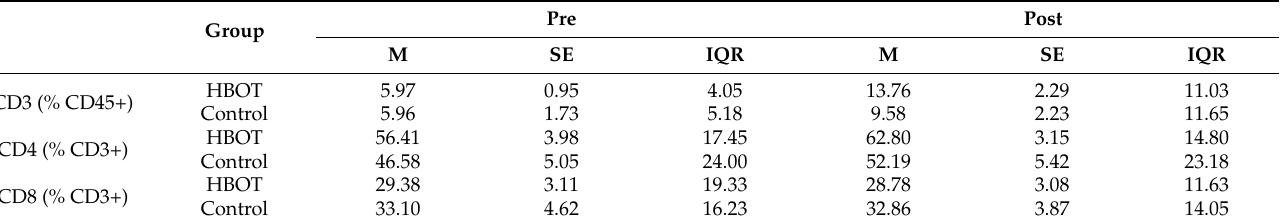
Table 4. Immunology for input and output results.